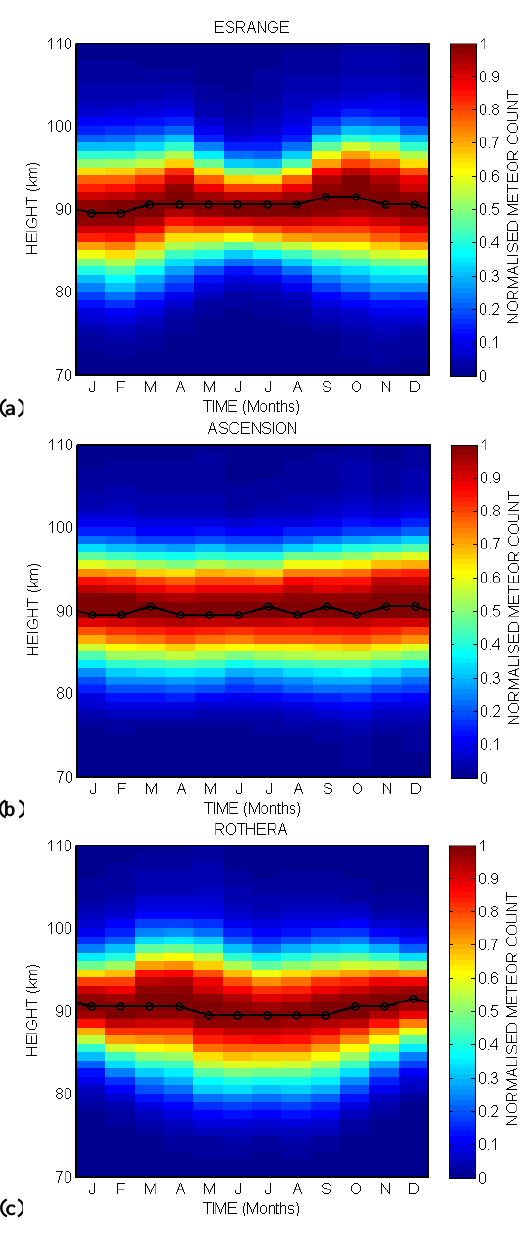
Fig. 4. Contour plots showing monthly mean height profiles at (a) Esrange in the period 2000 to 2006, (b) Ascension Island in the period 2001 to 2006 and (c) Rothera in the period 2005 to 2006. Note the annual variations in meteor count